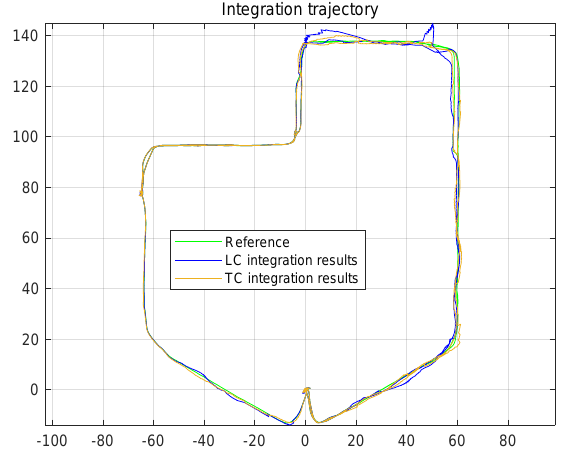
Figure 7: The integrated navigation results of track 2.